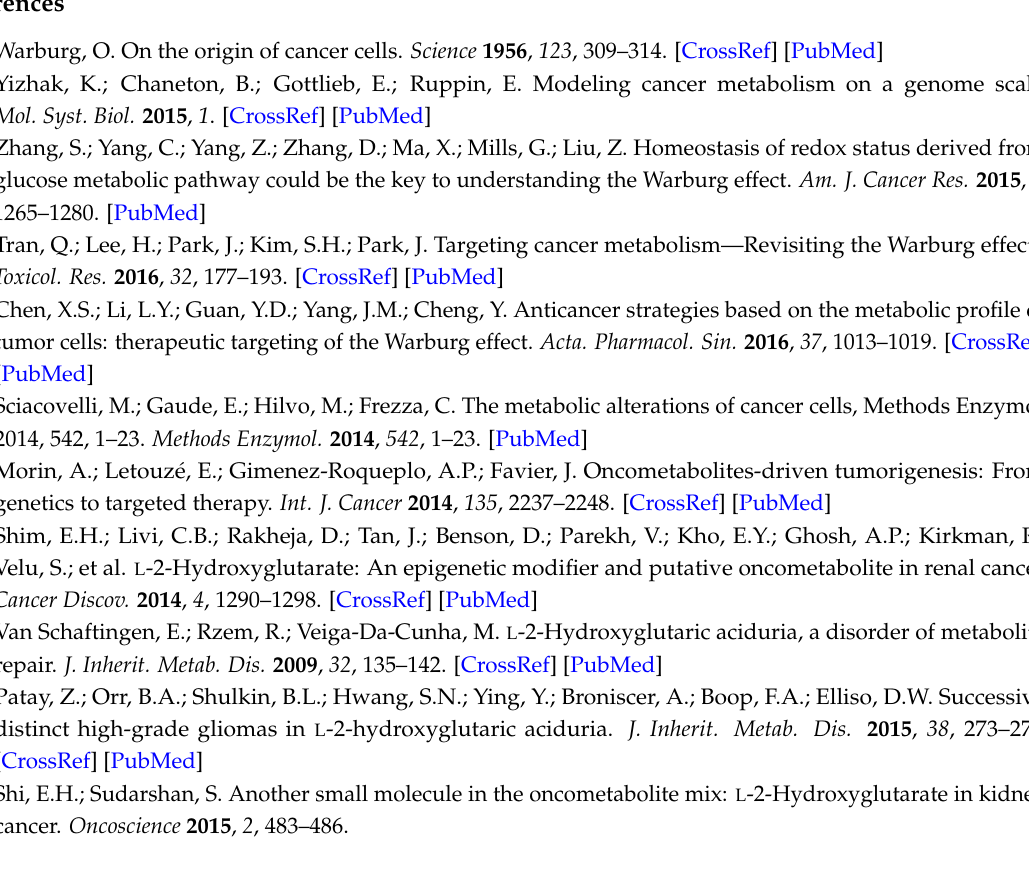
literature; Figure S2B: 3 C-NMR spectrum of L -2-hydroxysuccinamic acid ( L -2-HSM) produced from L